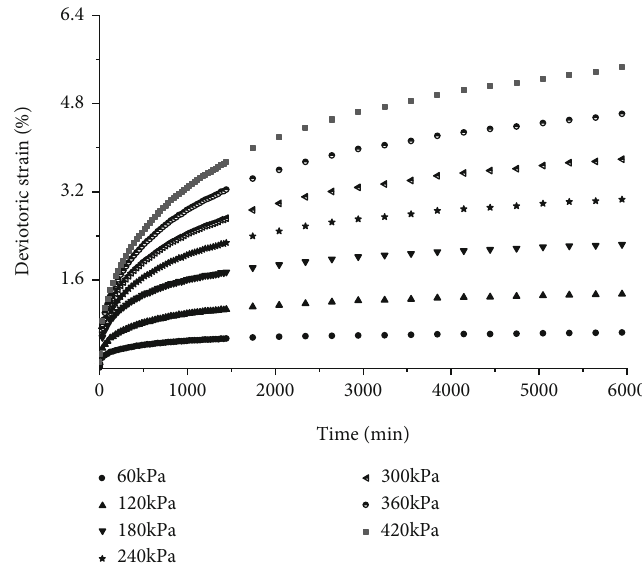
Figure 5: Deviatoric strain creep curve of intact soil.